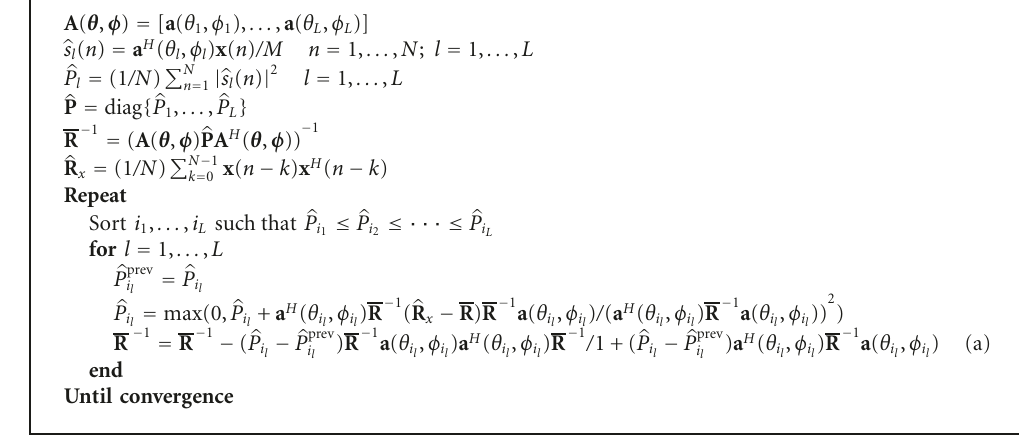
Algorithm 2: IAA-ML algorithm